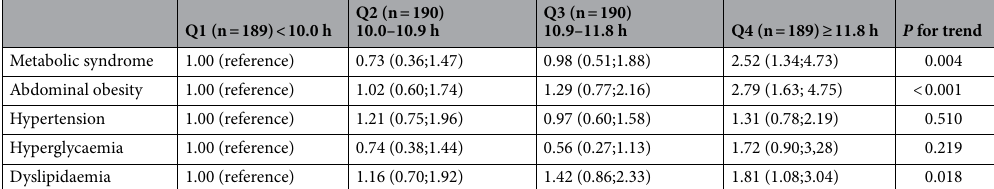
Table 3. Associations of sedentary time with metabolic syndrome and its components. Values shown are adjusted odds ratios (95% confidence intervals). Logistic regression models were used, with adjustment for age, sex, smoking status, alcohol intake, energy intake, and moderate-vigorous physical activity. Abdominal obesity: visceral fat area ≥ 100 cm 2 ; hypertension: systolic blood pressure ≥ 130 mmHg, and/or diastolic blood pressure ≥ 85 mmHg or using antihypertensive drugs; hyperglycaemia: fasting brood glucose ≥ 110 mg/ dL or using antidiabetic drugs; and dyslipidaemia: triglycerides ≥ 150 mg/dL and/or high-density lipoprotein cholesterol < 40 mg/dL or using antihyperlipidemic